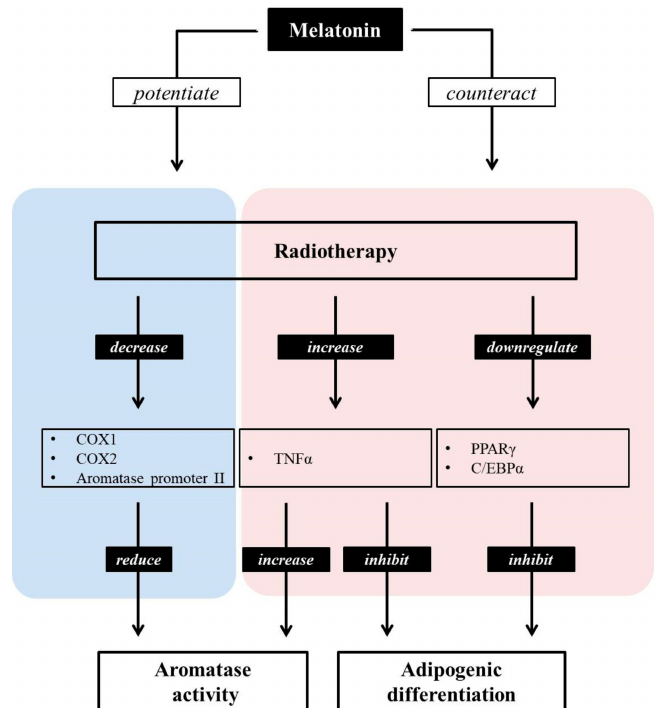
Figure 2. Melatonin can both potentiate and counteract the effects of radiotherapy. Radiation induces a decrease in adipocyte differentiation via downregulating PPAR γ and C/EBP α , as well as by increasing TNF α . Furthermore, it reduces aromatase activity by decreasing COX1/2 and aromatase promoter expression. The pineal hormone melatonin potentiates the inhibitory role of aromatase activity, counteracting its suppressive role in the adipocyte differentiation of radiotherapy. Moreover, the increase in aromatase activity following enhanced TNF α levels due to radiotherapy may be counteracted by